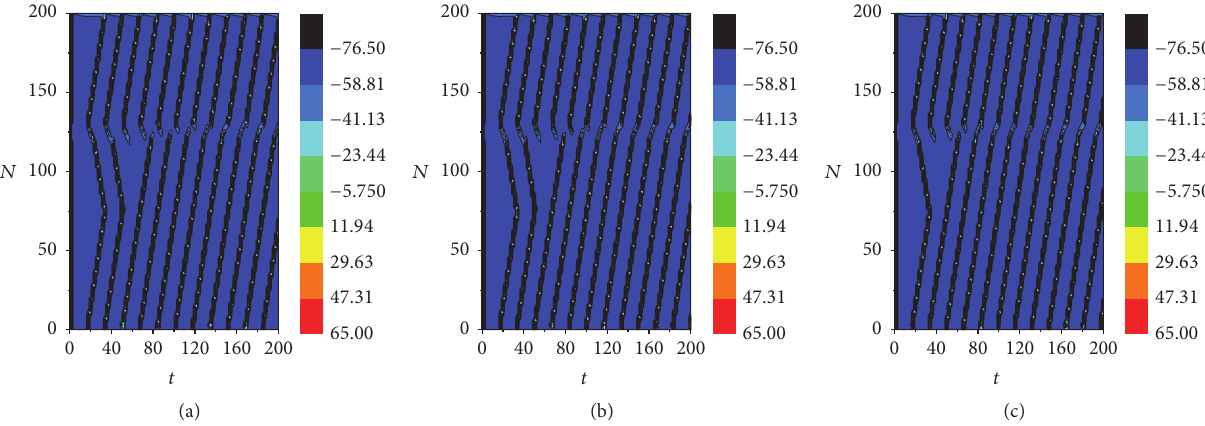
Figure 5: Wave propagation along axon when autapse is developed from node 𝑖 = 3, 135 , for gains (a) 𝑔 𝑐 = 10 , (b) 𝑔 𝑐 = 20 , and (c) 𝑔 𝑐 = 50 : the time delay in electric autapse is set as 𝜏 = 16 and external forcing 𝐼 ext = 20 is imposed on node 𝑖 = 3 . The injured area generated by decreasing the conductance of sodium from 𝐺 Na = 120 mS/cm 2 to 𝐺 Na = 25.5 mS/cm 2 : inhibitor chemical autapse is used by setting 𝑉 syn = −2 , the axon is divided into 201 nodes, and the injured area is marked from nodes 𝑖 = 120 to 130 . The snapshots are illustrated in color